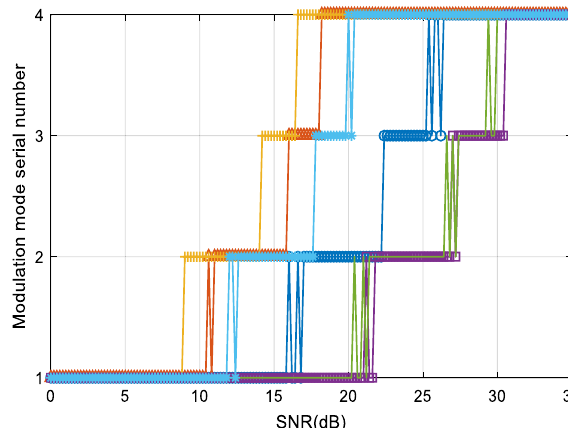
Fig. 12 The modulation mode serial number of SNR in some simulated